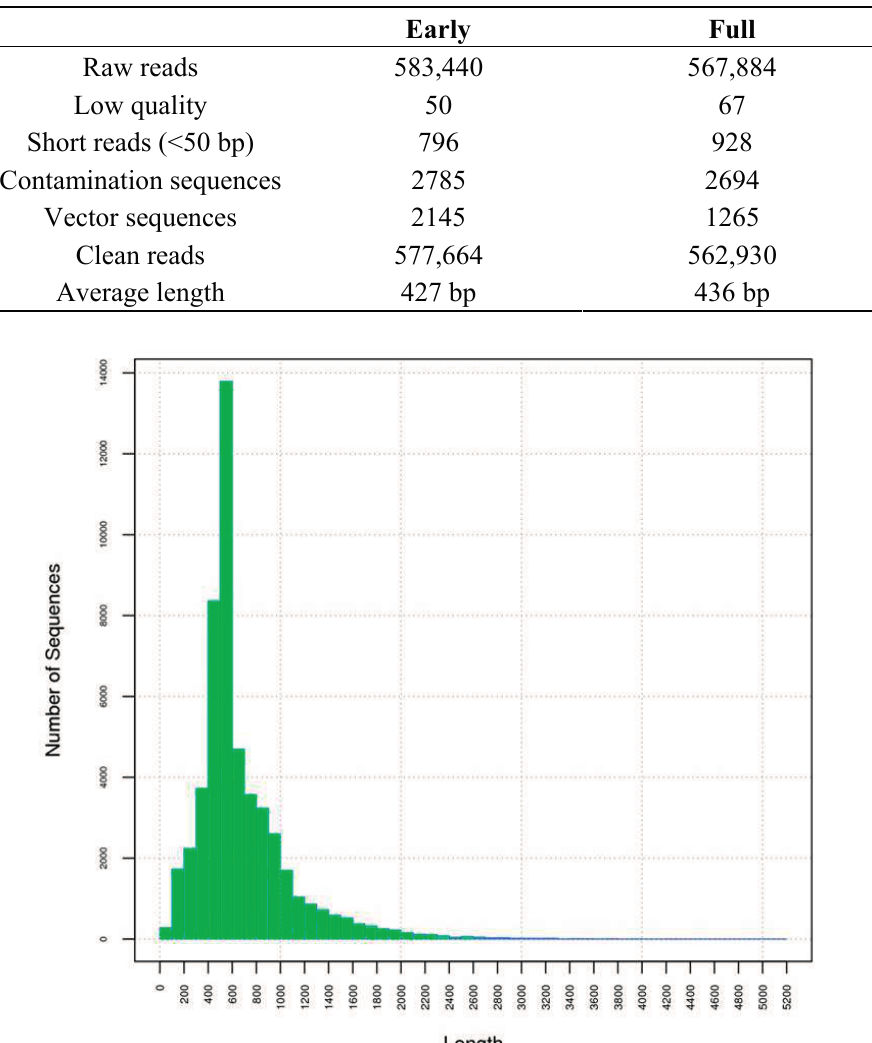
Table 1. Summary of the sequence assembly after 454 sequencing.